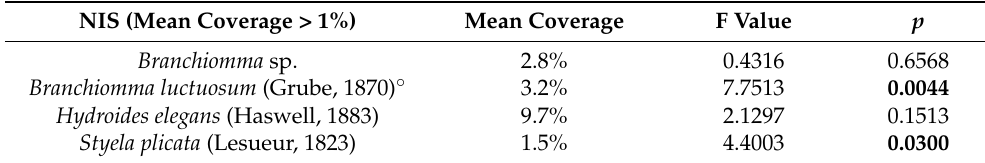
Figure 2. Boxplots of: ( A ) panel wet weight (B; g); ( B ); NIS richness (S NIS ); ( C ) native species richness (including cryptogenic species; S native ); ( D ) Shannon Index (H’); ( E ); NIS coverage (C NIS ; %); ( F ); native species coverage (C native ; %). Data were grouped by experimental treatment levels: C: control panels, (i.e., uncaged); OCa: open-caged panels, (i.e., artifact control); Ca: caged panels. “×” in the plots indicates mean values. Core lines show median values, the box size is based on the interquartile ranges and whiskers show minimum and maximum values. Significant variables are marked with an asterisk (*). Table 1. Summary of the ANOVA tests on mean coverage of selected NIS (with total mean coverage among all plates above 1%). ◦ : ANOVA test on square root- transformed data. Significative p values are in